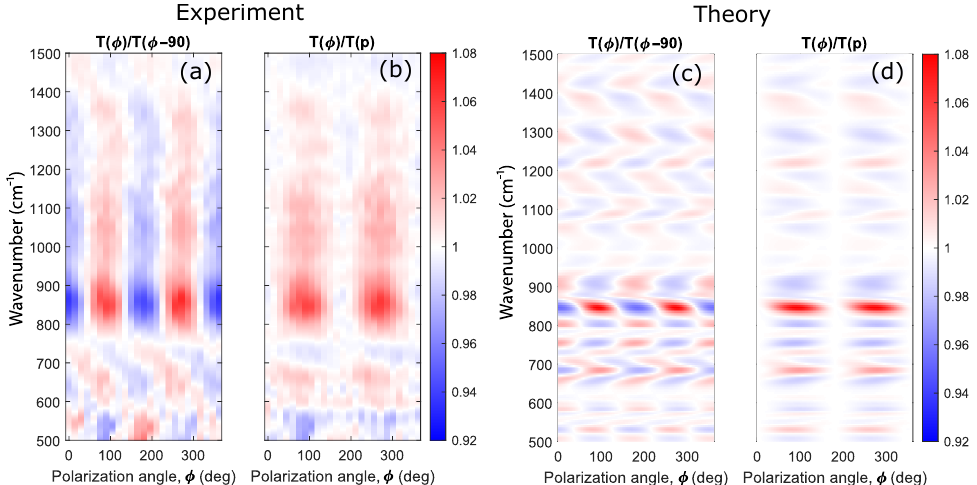
Figure 10. Experimental ( a , b ) and theoretical ( c , d ) dependencies of the T ( φ ) / T ( φ − 90 ◦ ) ( a , c ) and T ( φ ) / T ( p ) ( b , d ) on the angle of polarization φ and the wavenumber ω / c . Calculations are made for the polar angle of incidence θ = 1 ◦ . The color scale is shown on the